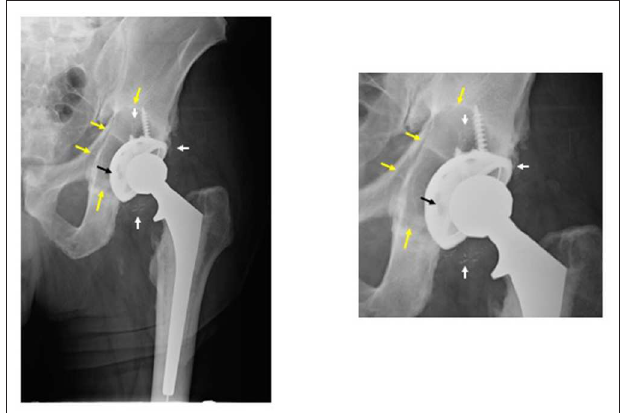
FIGURE 1 | Periprosthetic osteolysis post total hip replacement (THR). The left radiograph shows a hybrid THR with a cemented stem and a cementless cup with screws. The components are well fixed, however, there is polyethylene wear and the metallic cup has fractured adjacent to the screw holes (note: two of the screw holes are larger than they should be and confluent instead of separate—black arrow). The small white radio-dense particles represent metallic debris from the cup (white arrows). There is a large radiolucent black area of bone destruction (osteolysis) (yellow arrows) surrounding the acetabular component. The radiograph on the right is a magnified view of the acetabular